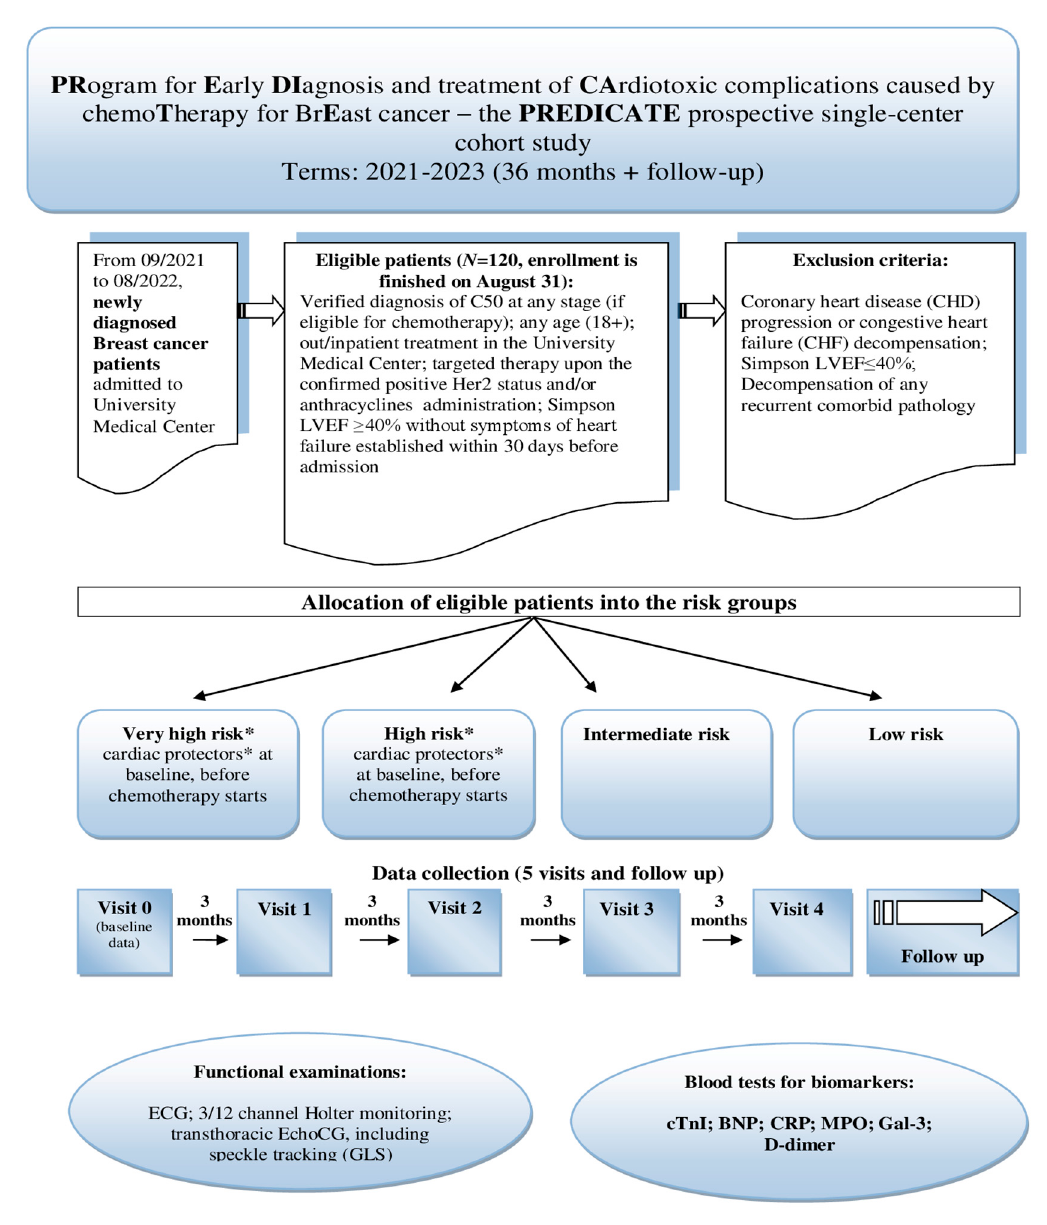
Figure 1. Design of the prospective cohort study.*“Very high” risk means presence of existing chronic heart failure or dilated cardiomyopathy, according to the current position papers on CTRCD [17,23–25]; “high” risk includes previous severe valvular heart disease, past myocardial infarction and/or revascularization, baseline left ventricular ejection fraction <50%, stable angina, or prior treatment with anthracyclines or radiation therapy (see Section 2.1.7). * Cardiac protectors: ACE inhibitors/ARBs; beta-blockers; statins; trimetazidine/analogues; others (see Section 2.1.5).